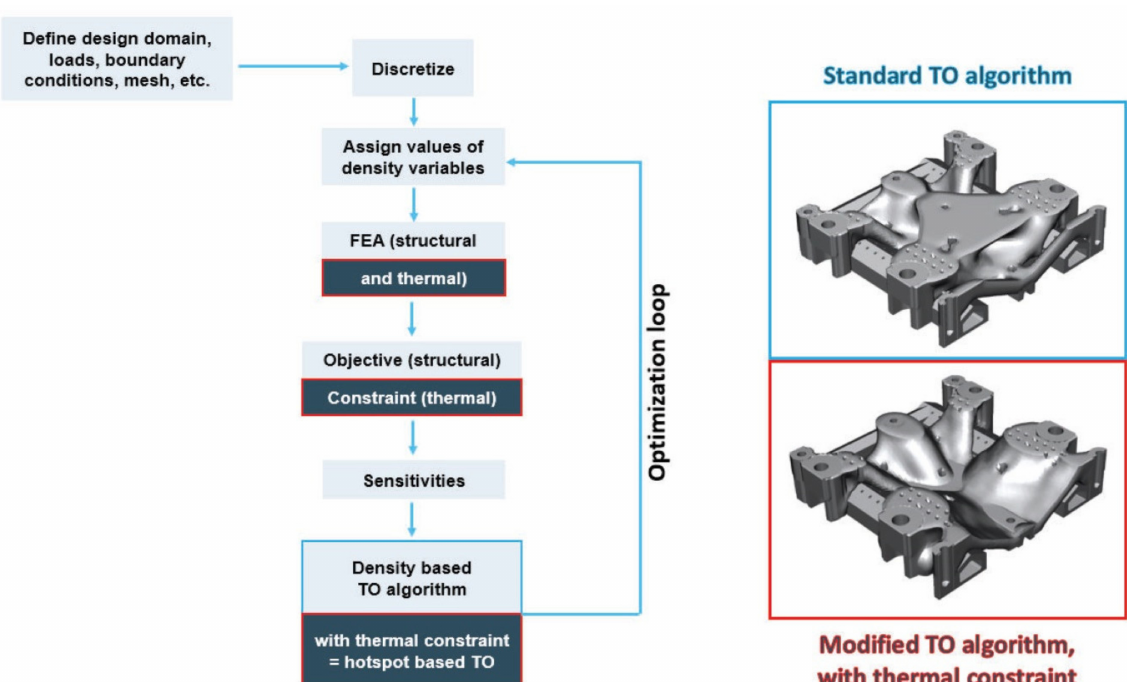
Figure 32. The injection molding insert, topology optimized with the standard density-based topology optimization (TO) algorithm and the in-house novel TO algorithm with AM thermal constraint (hotspot detection) [145]. The topology optimized inserts have the same dimensions as the original, Figure 31. For simplicity, the authors display only half of each insert (110 mm × 110 mm × 25 mm) in this figure